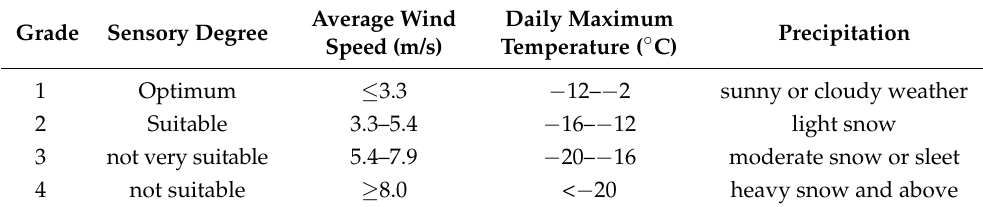
Table 2. Grading standard for ice–snow tourism index in Jilin